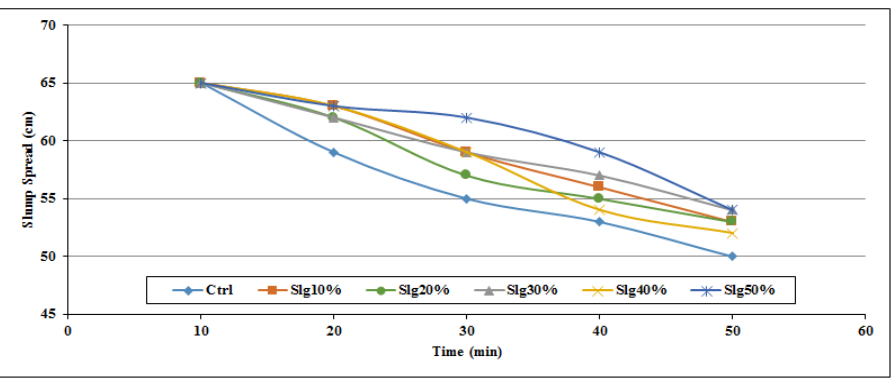
Figure 7. Slump loss diagram for slag powder samples throughout the first 50 min.